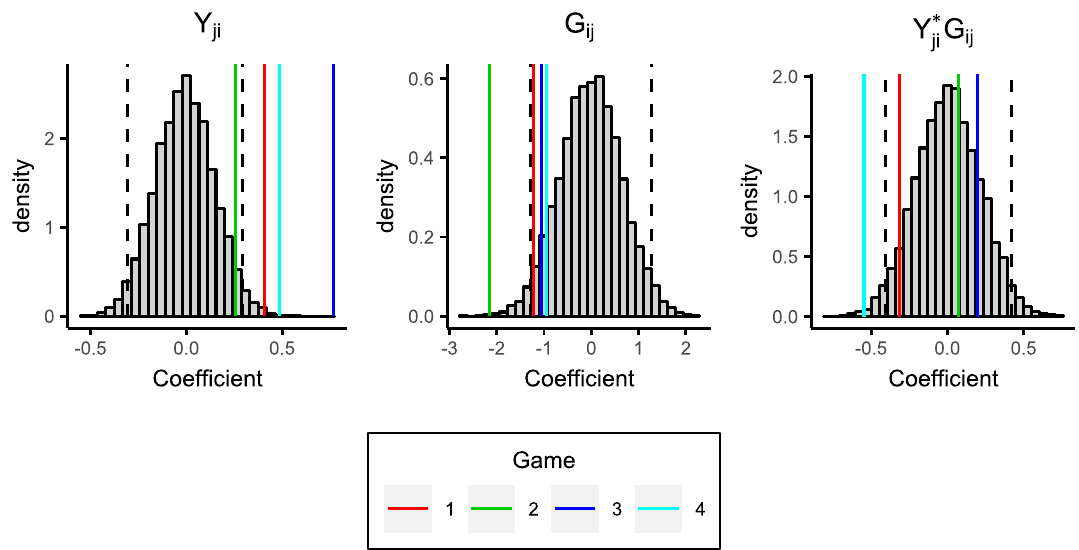
Figure 6. Coefficients for the interaction effects models. Game coefficients are the vertical coloured lines. The histograms show the model coefficients from synthetic giving-at-random null games. 95% of values lie between the black dashed